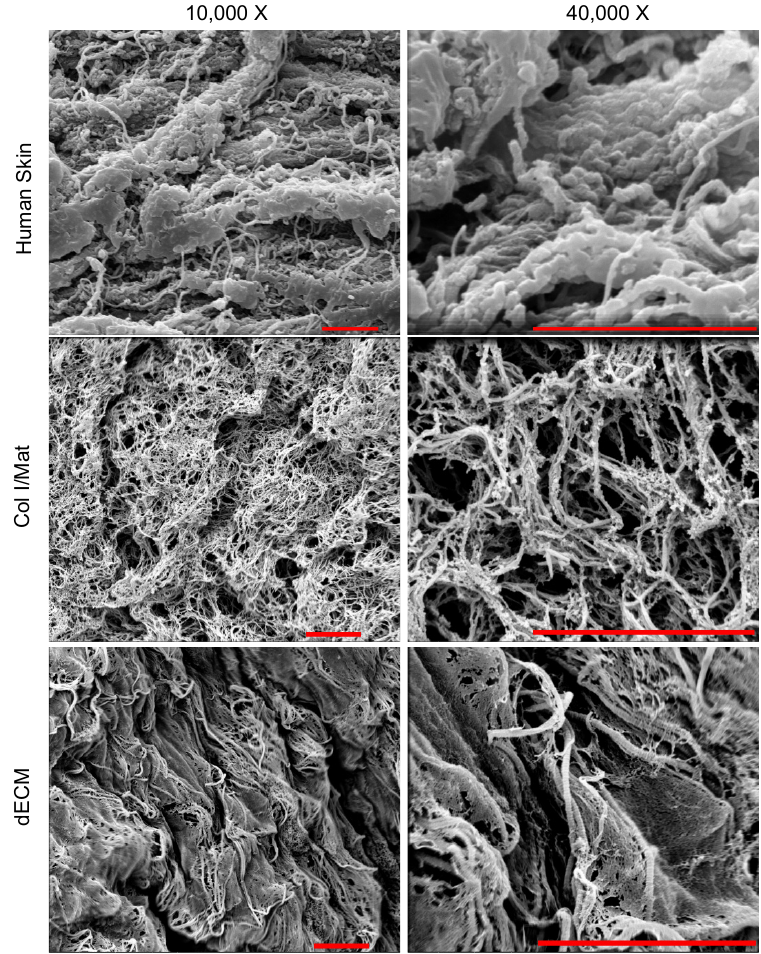
Figure 2. Nanostructure of human skin, and Col/Mat and dECM hydrogels. Human skin images were captured from fresh human abdomen skin. Col/Mat and dECM hydrogels were neutralized and cured at 37 °C for one hour before being fixed and processed for scanning electron microscopy. Scanning electron micrographs were obtained at 10,000× and 40,000× magnification for both gels. Scale bars represent 4 μ m.